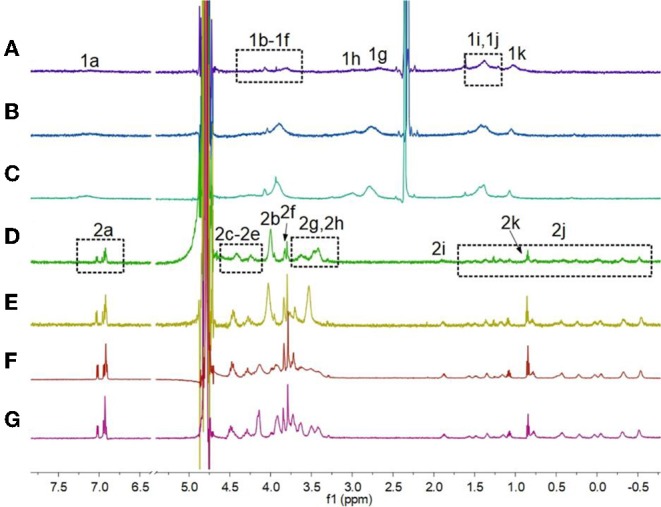
Partial 1H NMR spectra (600 MHz, 3:1 D2O/CD3CN, room temperature) of H1 (2.50 mM) under different pH conditions: (A) pH 7.0, (B) pH 6.0, (C) pH 5.0; partial 1H NMR spectra (600 MHz, D2O, room temperature) of H1 (2.50 mM) under different pH conditions: (D) pH 4.0, (E) pH 3.0, (F) pH 2.0, (G) pH 1.0.